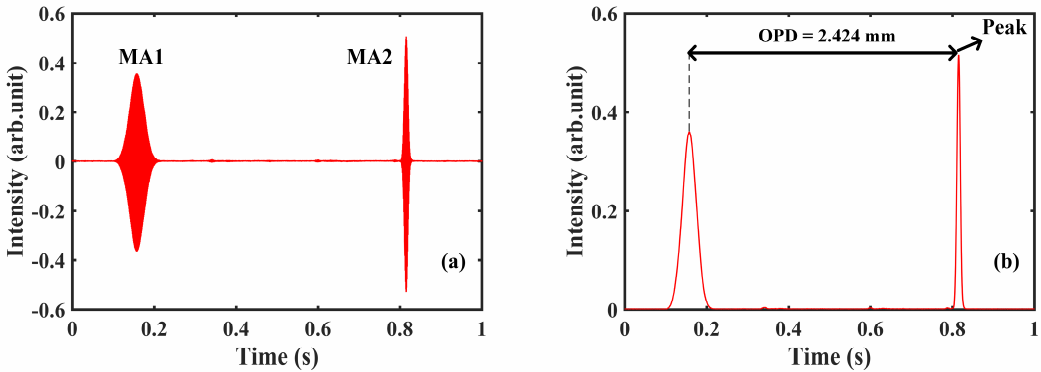
Figure 3. ( a ) Cross-correlation patterns with water in the tank; ( b ) results of the Hilbert transform.